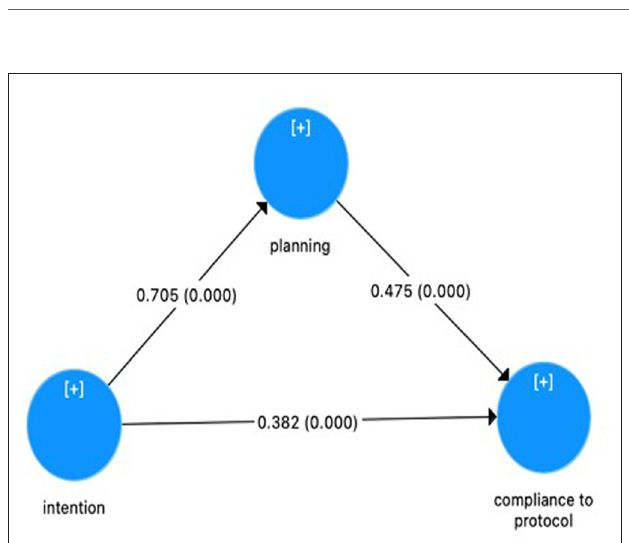
FIGURE 3 | Mediation analysis.